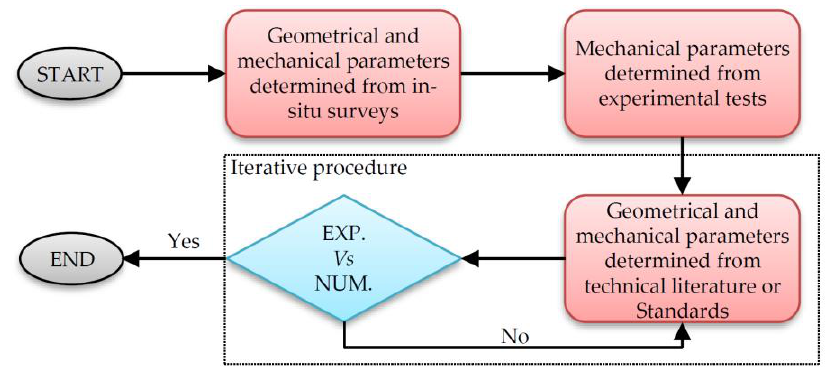
Figure 1. Flowchart describing the modelling strategies to be adopted within a framework for the building model updating.